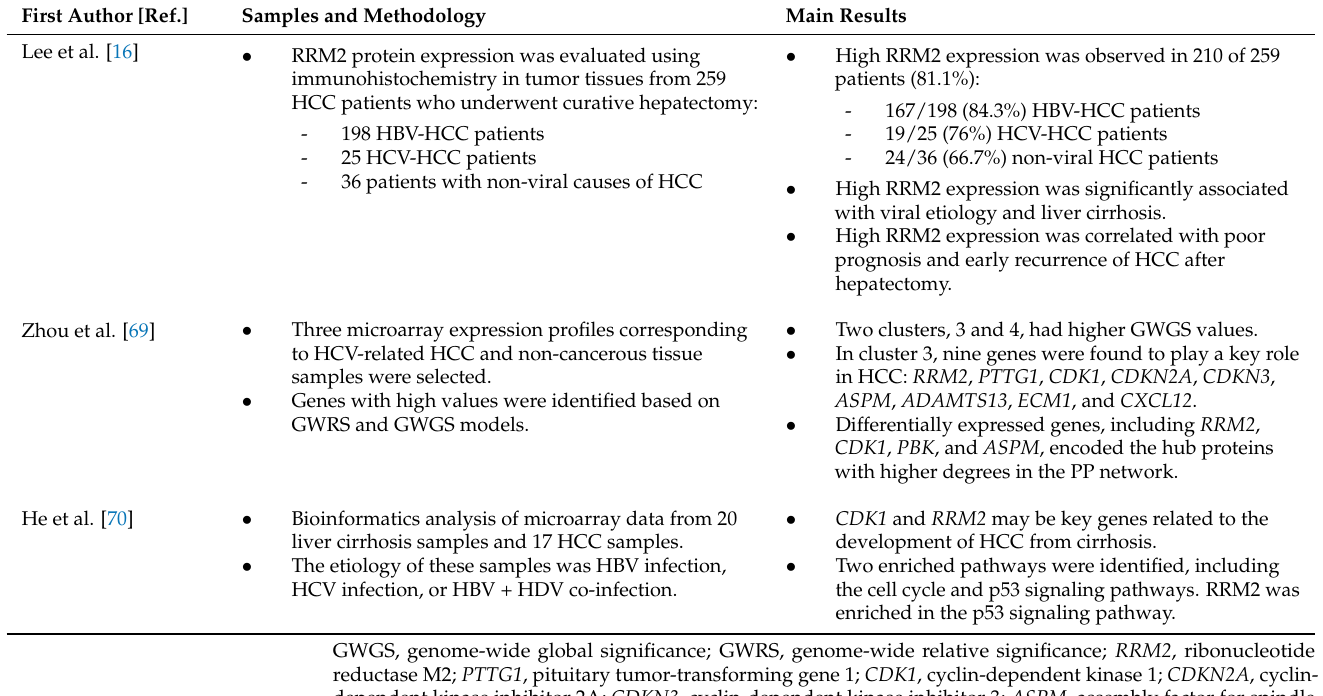
Table 1. Main studies that have investigated RRM2 expression in HCV-associated HCC.